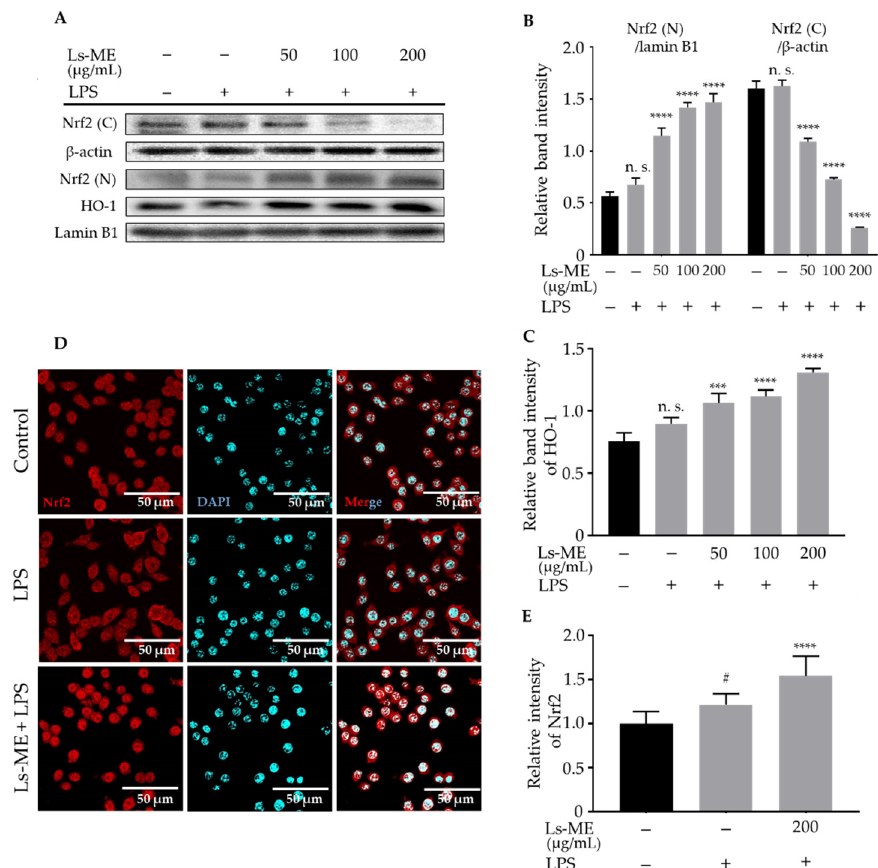
Figure 7. Ls-ME promoted the Nrf2 / HO-1 activation. Cells were cultured with serial concentrations of Ls-ME for 24 h, followed by treatment with LPS (1 µ g / mL) for 18 h. The expression of Nrf2 in the cytosol (C) and nucleus (N) fractions, and HO-1 in the whole-cell lysate was determined using Western blot ( A ). Relative band intensities of Nrf2 / β -actin, Nrf2 (N) / lamin B1 ( B ), and HO-1 / lamin B1 ( C ) were quantified using Image J. The cells were cultured in medium only (control), LPS only (1 µ g / mL), or Ls-ME (200 µ g / mL) followed by LPS (1 µ g / mL) and were stained with the Nrf2 antibody labeled with Alex Fluor 594 (red) and DAPI (blue). Representative images are shown in ( D ) with the red color of Alexa-594. Control, cells incubated alone; LPS, cells incubated with LPS; Ls-ME + LPS, cells incubated with Ls-ME (200 µ g / mL), then treated with LPS. The fluorescent intensities were analyzed by MetaMorph ( n = 35) ( E ). Scale bar indicates 50 µ m. Data of the three replicates are represented as mean ± SD. # p < 0.05 is expressed in comparison with cells incubated alone; *** p < 0.001; **** p < 0.0001 is expressed in comparison with LPS treatment only; n. s., not significant.